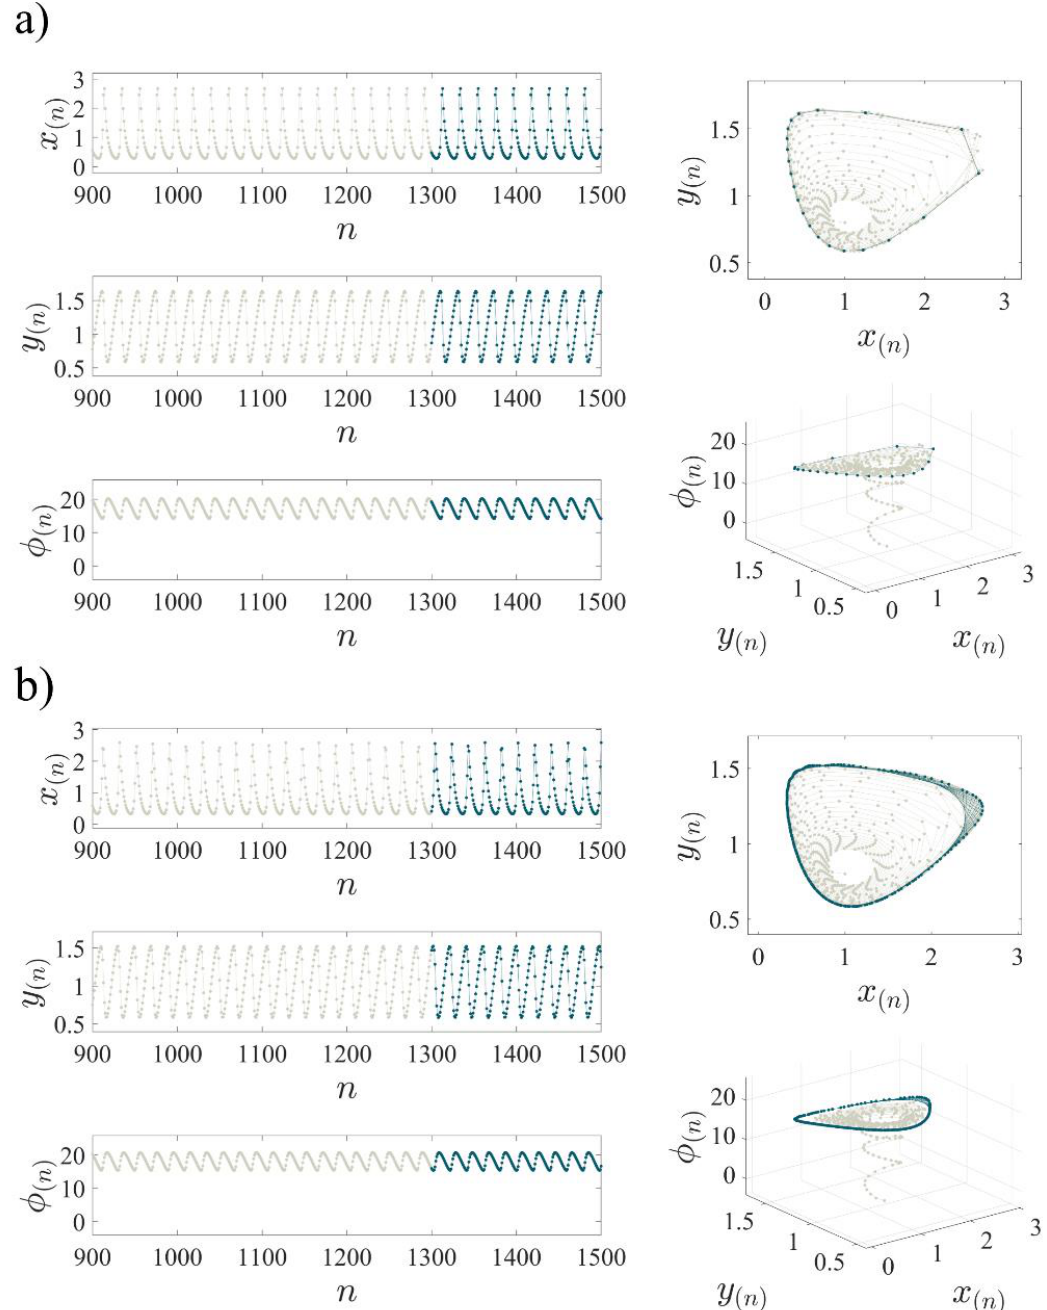
Figure 4. Time series of x , y , and φ (Left column) and 2D state space projections of 3D-MCM in the x - y plane and 3D state space projections in the x - y - φ plane (right column) with the initial conditions ( x ( 0 ) , y ( 0 ) , φ ( 0 )) = ( 1.0, 0.8, 0.2 ) . The periodic oscillation occurs for k = 0.148 ( a ), and the chaotic oscillation occurs for k = 0.152 ( b ). The other parameters are set, as mentioned in Table 1. The 3D-MCM’s basin of attraction in the x - y plane is illustrated in Figure 5, where the initial condition ( x ( 0 ) , y ( 0 ) , 0.2 ) leading to chaotic bursting (quiescent) mode is illustrated in purple (blue). The system’s parameters are set, as mentioned in Table 1. According to the diagram, selecting different initial conditions with the same parameters results in different